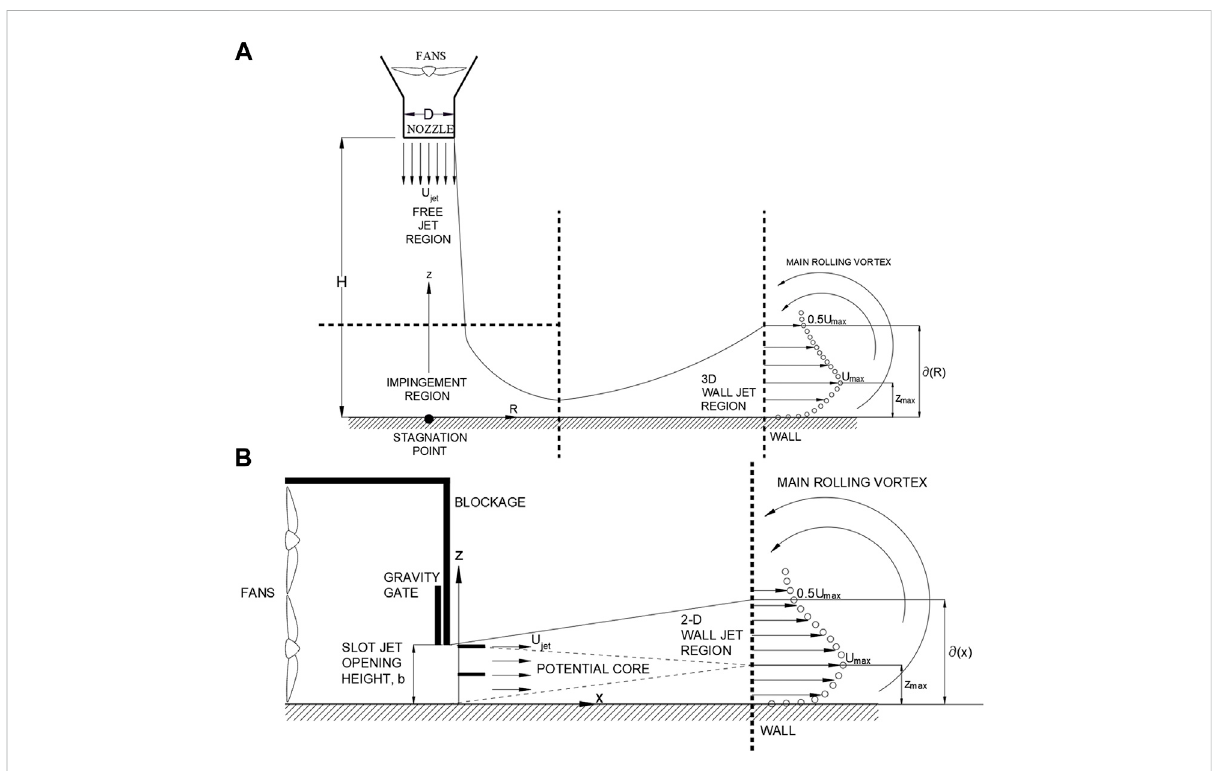
FIGURE 1 (A) Impingement jet model, credit: Sengupta and Sarkar, 2008. (B) 2-D Wall jet test model, credit: Lin and Savory, 2006;